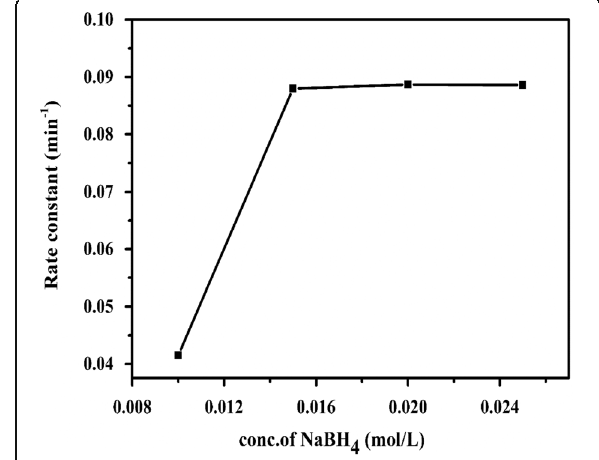
Fig. 10 Plot of rate constant versus concentration of NaBH 4